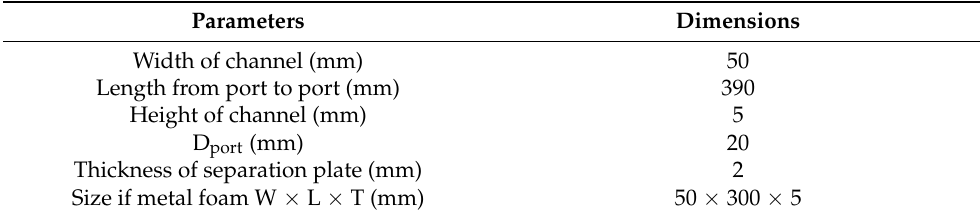
Figure 2. ( a ) Images of the parts and assembled test section and ( b ) detail cutting view of the test section. Table 2. Dimensions of the test section and metal foam.